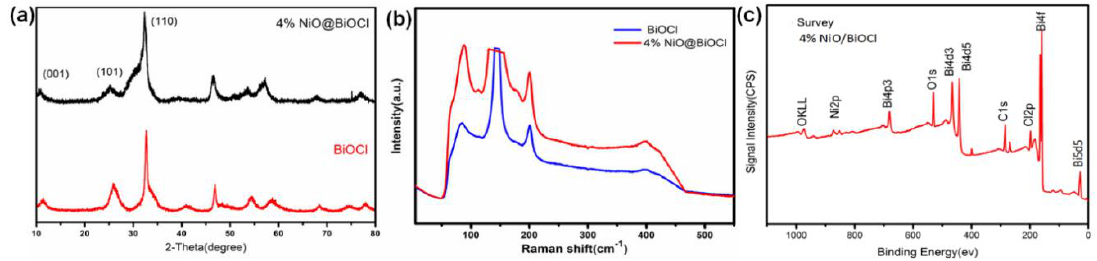
Figure 2. XRD patterns ( a ) and Raman spectra ( b ) of samples and XPS total survey of4% NiO@BiOCl ( c